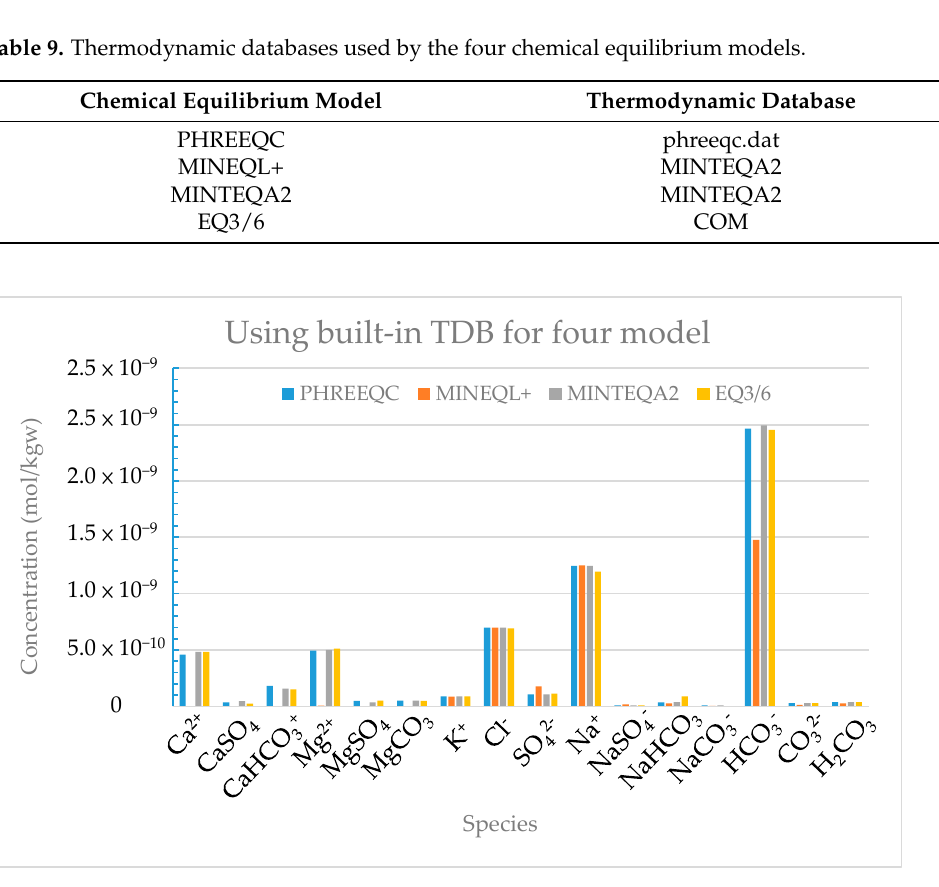
Figure 7. The solution concentration calculated by the Davies equation using the built-in thermody- namic database of the four models.